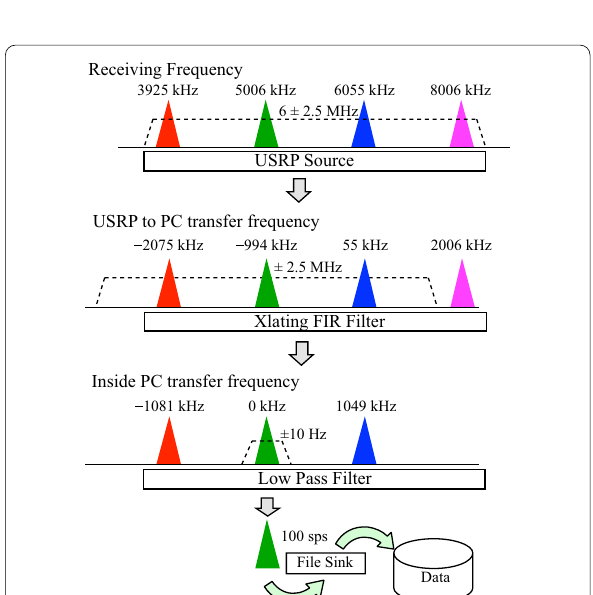
Fig. 4 Schematic showing the signal processing in the USRP/PC